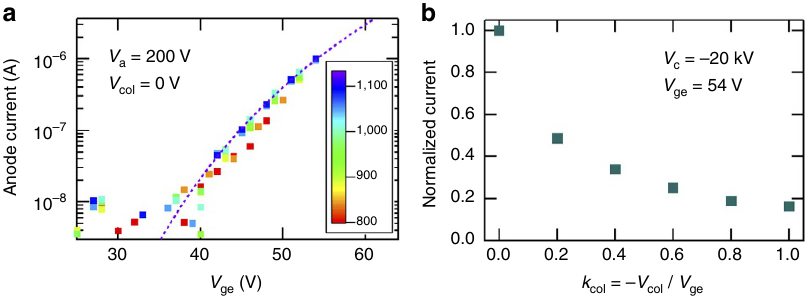
Figure 2 | Field emission characteristics of double-gate FEA. ( a ) The evolution of the field emission characteristic of the studied double-gate FEA device measured at low anode potential V a equal to 200V, zero cathode potential and the zero collimation potential ( V col ) displayed as the relation between the current I collected at the anode and the electron extraction potential V ge . The I – V ge scan was repeated by 1,311 times until the I – V ge characteristic became stable. Some of the scans between 801th and 1,311th of which scan numbers were denoted by colour bar are displayed. The dotted curve is the fitting. ( b ) The variation of the field emission current with the increase of beam collimation strength denoted by k col ¼ (cid:2) V col / V ge at V ge of 54V, the cathode potential of (cid:2) 20kV and the anode potential of 0V.